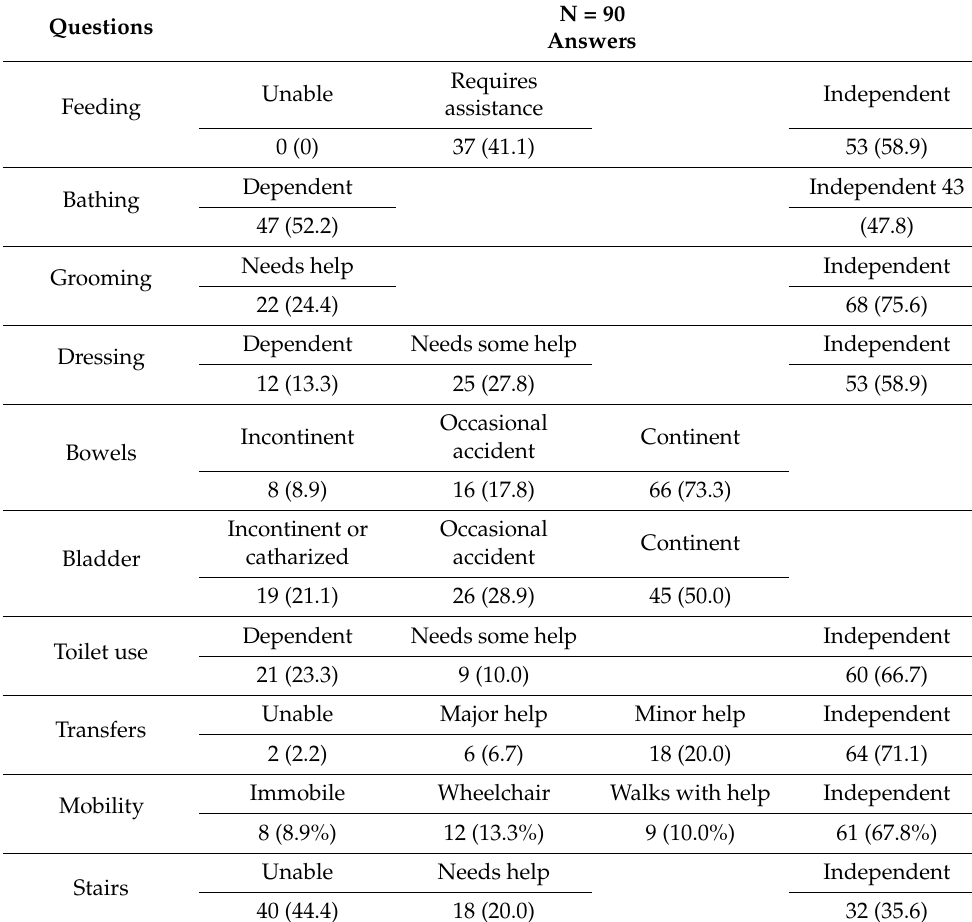
Table 2. Results for the Barthel 20